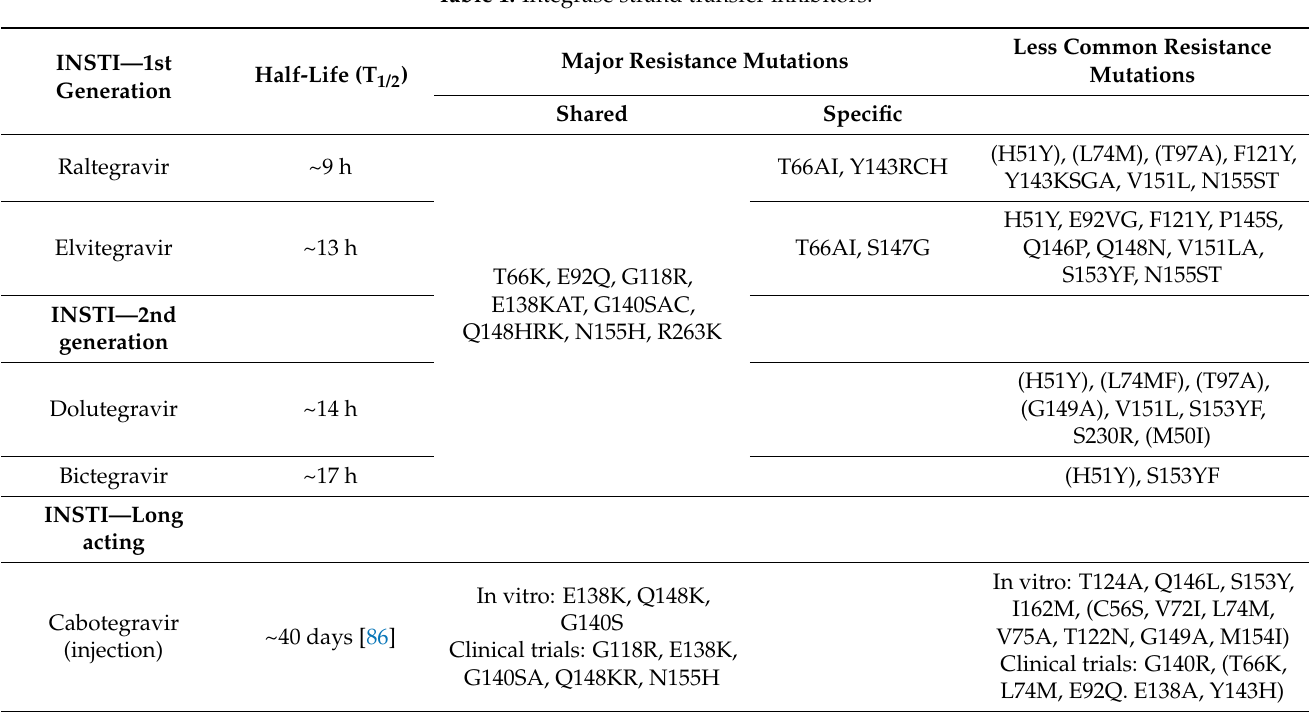
Table 1. Integrase strand transfer